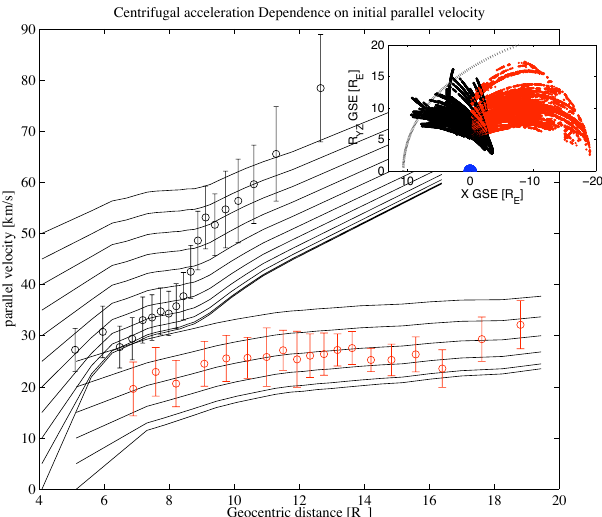
Fig. 3. Parallel velocity as function of the geocentric distance. The x-axis shows the geocentric distance [ R E ], the y-axis shows the par- allel velocity as observed in the lobe region (red circles with error bars) and for the cusp/mantle ion outflow (black circles with error bars). Velocities resulting from average observed centrifugal ac- celeration as function of different initial values at 5 R E (lobes) and 4 R E (cusp/mantle) are shown with solid black lines. Error bars in- dicate 95% confidence level for normal distributed data, based on both variance of orbit average values and variance of all measure- ment points. Inserted in the top right of the main figure is a figure p Y 2 + Z 2 coordi- indicating where the data was taken in X, R = nates [ R E ], black dots for the cusp/mantle and red dots for lobe data points (i.e. from this